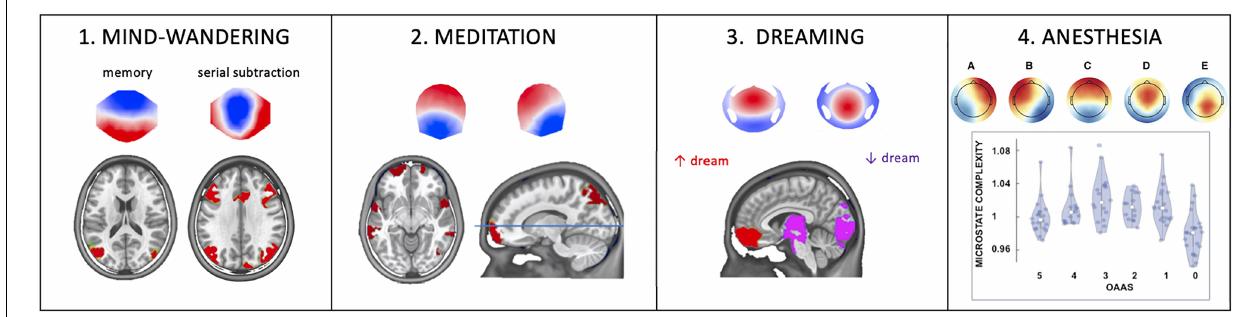
FIGURE 1 | The influence of different functional brain states on EEG microstates. (1) Instructing subjects to focus their thoughts on an autobiographical memory increased duration and occurrence of one microstate, while focusing the attention on a serial subtraction task increased duration and occurrence of another microstate. Source localization attributed the memory-specific microstate to the lateral parietal lobe and the arithmetic-specific microstate to the activity of a frontoparietal network (Figure modified with permission from Bréchet et al., 2019). (2) Compared to placebo, six weeks of digital meditation training led to a reconfiguration of two of the four predominant microstates whose generators were found in the superior frontal gyrus, the superior temporal gyrus, the insula, the left inferior, and the right superior parietal lobule (Figure modified with permission from Bréchet et al., 2021). (3) EEG microstates during dreaming: compared to awake, Non-Rapid Eye Movement Sleep (NREM), dominated by slow-wave activity, selectively increased the Global Explained Variance and duration of two out of five microstates which were localized in the medial and middle frontal gyrus and the posterior cortex and midbrain, respectively. Interestingly, dreaming during NREM sleep further increased the presence of the frontal microstate but decreased the presence of the posterior microstate, indicating a local awakening (less slow-wave) of the posterior cortex (Figure modified with permission from Bréchet et al., 2020). (4) EEG microstate during global anesthesia. All five microstates identified in this study were modulated in the same way by different levels of Propofol: they first showed an increase in occurrence and complexity and decrease in duration with moderate sedation, but an inverted behavior with deeper sedation. This u-shaped behavior might be linked to the paradoxical excitation induced by moderate levels of Propofol. OAAS refers to the Observer’s Assessment of Alertness/Sedation scale ranging from 5 (awake) to 0 (deep anesthesia) (Figure modified with permission from Artoni et al.,